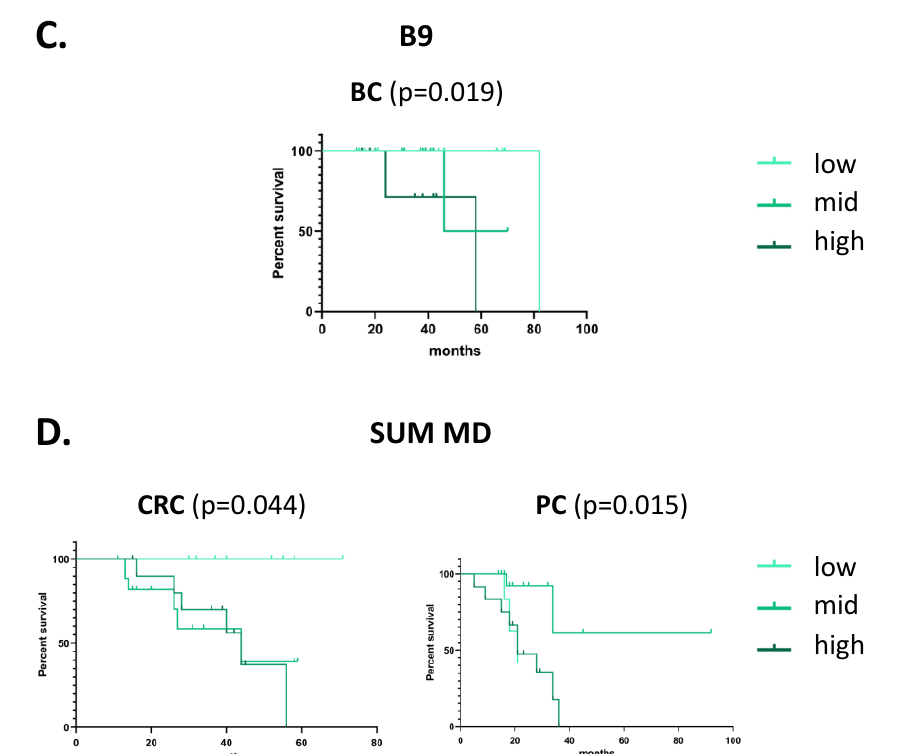
Figure 4. Overall survival of the breast, colorectal and pancreatic cancer patients based on their daily intake of methyl-donors. BC: breast cancer, CRC: colorectal cancer, PC: pancreatic cancer, B6: vitamin B6 intake, B9: vitamin B9/folate, and SUM MD: total methyl-donor intake.